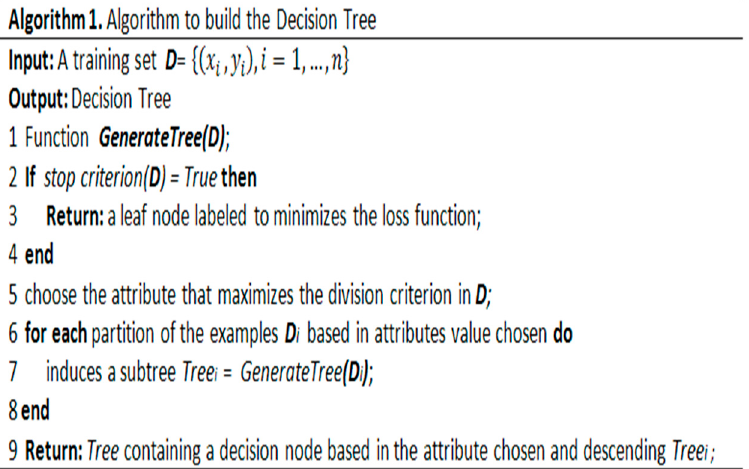
Figure 3. Generic decision tree algorithm.